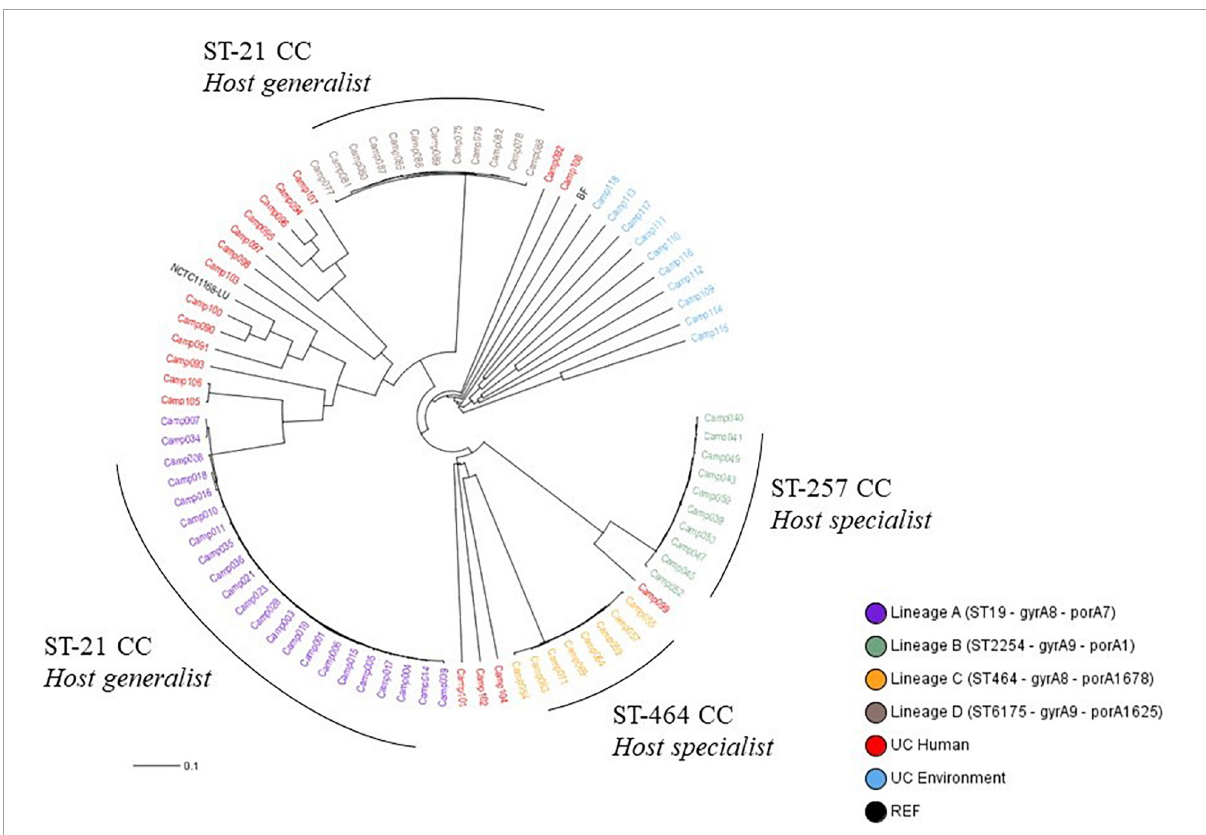
FIGURE1 UPGMA phylogenetic tree for 83 Campylobacter jejuni isolates based on the cgMLST Oxford allelic profiles (1,343 loci). CC refers to Clonal Complex, NCTC11168 is a reference strain, and Bf was used as a positive control for aerobic acclimation and biofilm formation, ST to sequence type, and UC to unique